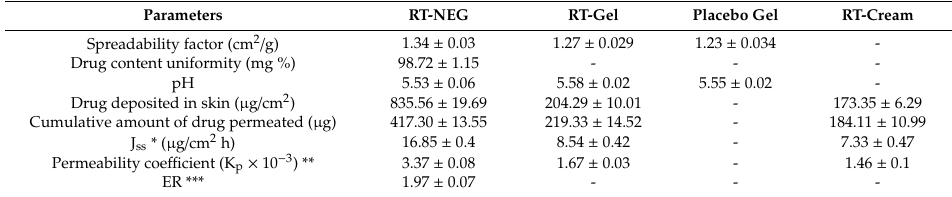
Table 4. Characterization of the gel formulations from the skin permeation and deposition